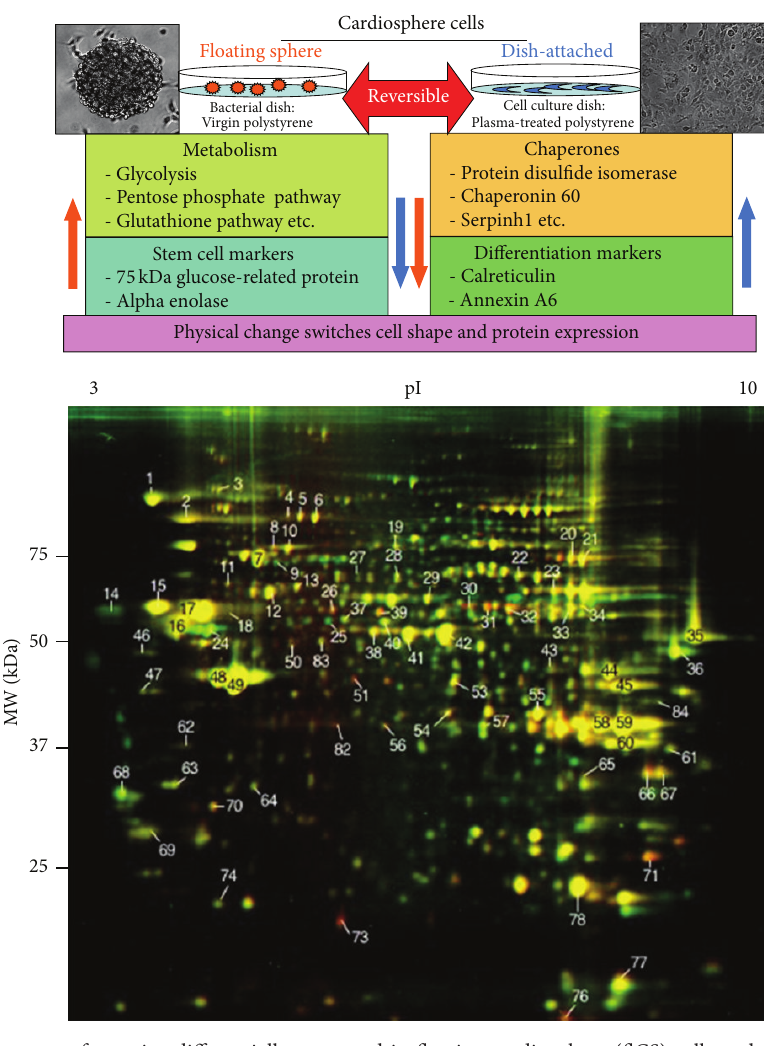
Figure 1: Upper Panel: Category of proteins differentially expressed in floating cardiosphere (flCS) cells and dish-attached cardiosphere (daCS) cells reported in Machida et al. [20]. Among the proteins successfully identified, about 44% were differentially expressed. Lower Panel: Comparative 2D-DIGE of CSC-21E whole cell lysates from flCS (red) and daCS (green) cultures. Proteins with similar amounts in flCS and daCS appear as yellow spots, whereas proteins differentially expressed show reddish (more abundant in flCS) or greenish (more abundant in daCS) spots. The figure was modified from Figure 3 of Machida et al. [20] with